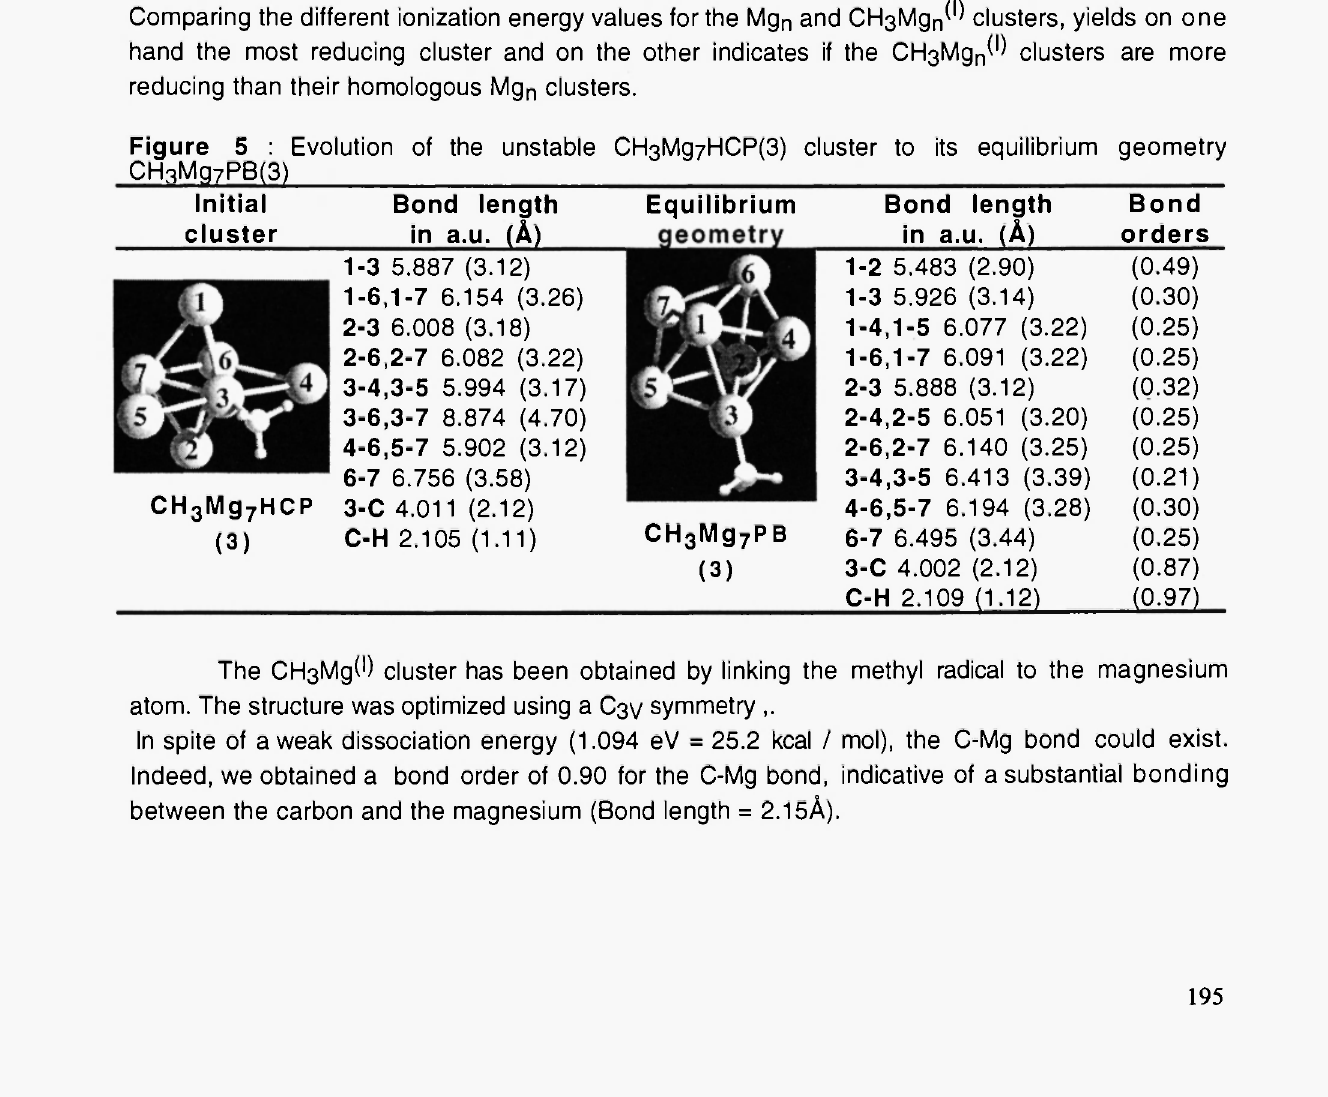
CH3Mg7HCP(3) cluster to its equilibrium